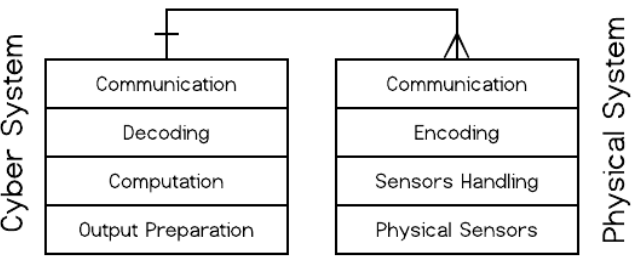
Figure 4. Stacked operation layers showing the one-to-many relationship between the Cyber and the Physical systems.